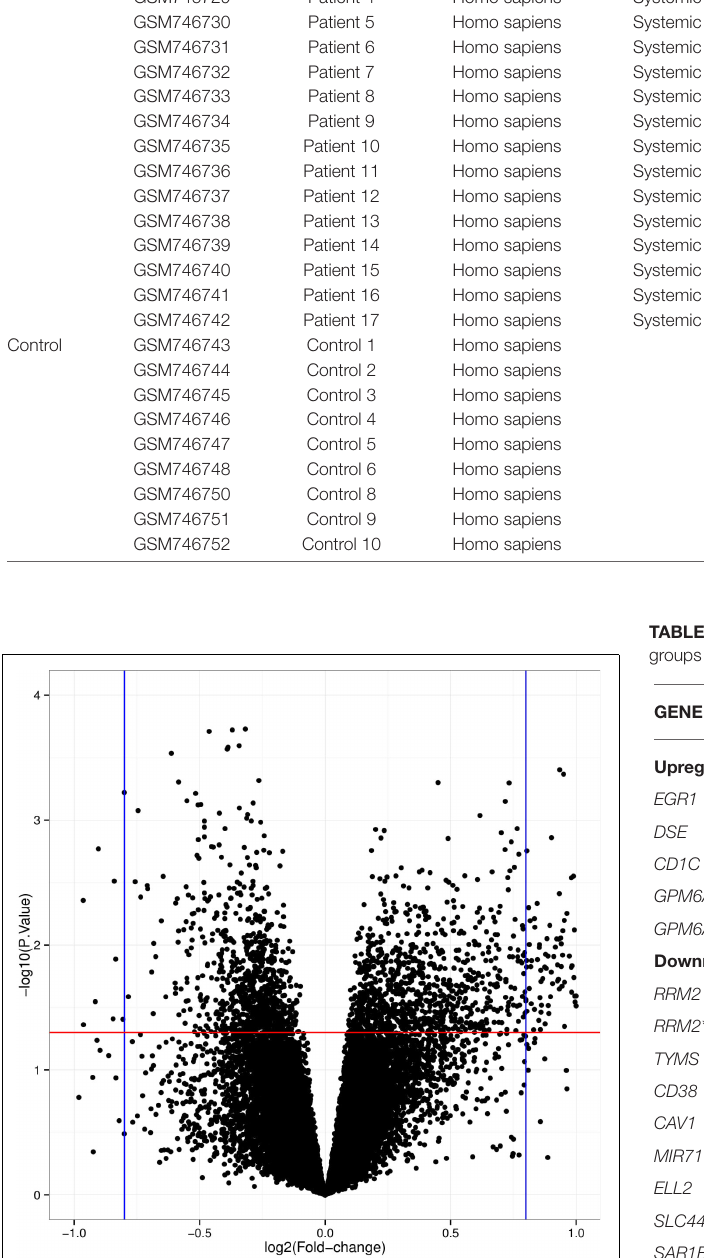
FIGURE 1 | Pictorial representation of volcano plot for differentially expressed genes (DEGs) in systemic lupus erythematosus (SLE) compared to controls from the GSE30153 dataset. The X-axis represents Log2FC, large magnitude fold changes; Y-axis represents − log10 of a p -value, high statistical significance. Each black dot represents one gene. Black dots above red and beside blue line (left-sided and right-sided) are log2FC ≥ 1 and p -value < 0.05, representing SLE related DEGs.